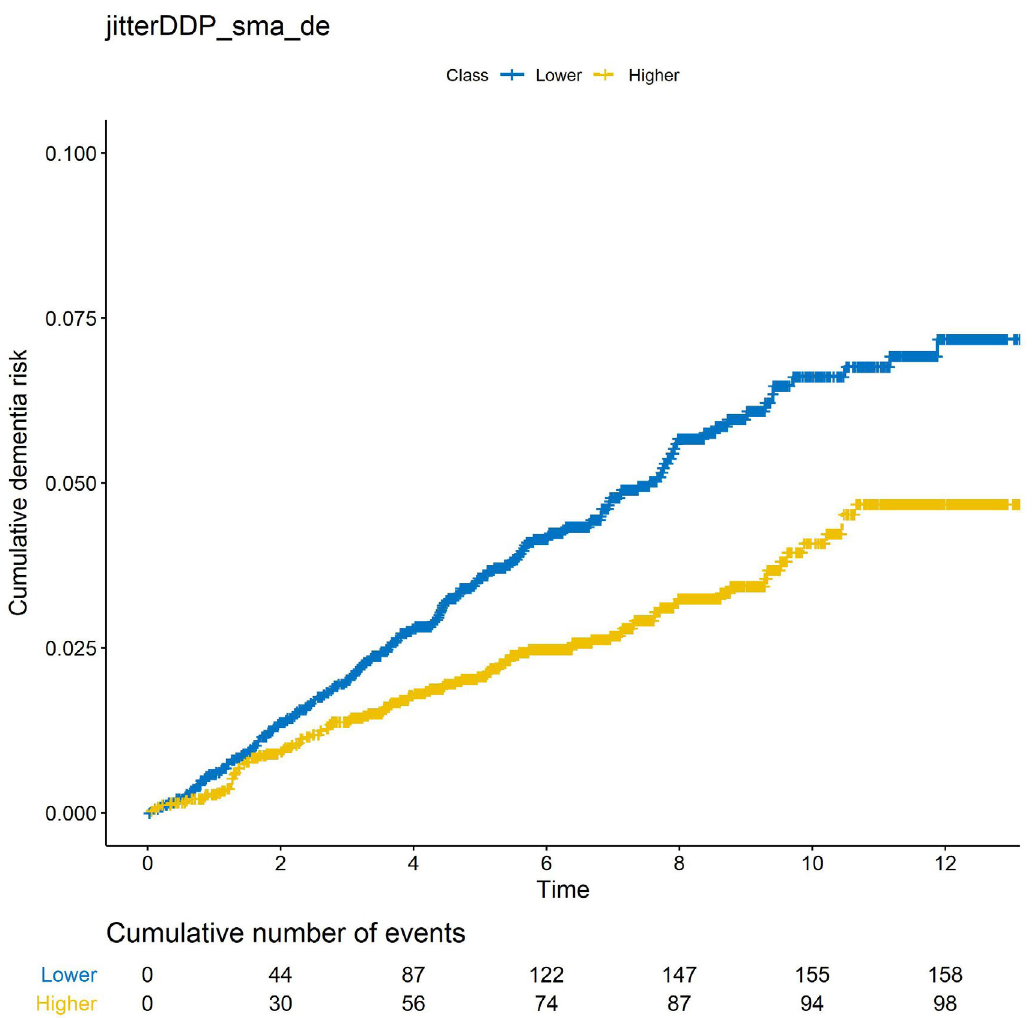
Figure 2. Cumulative dementia risk among participants with low jitterDDP_sma_de or higher jitterDDP_sma_de. The X-axis is the follow-up time in years, and Y-axis is the proportion of cumulative dementia risk. The cumulative number of dementia events in every two years is also shown